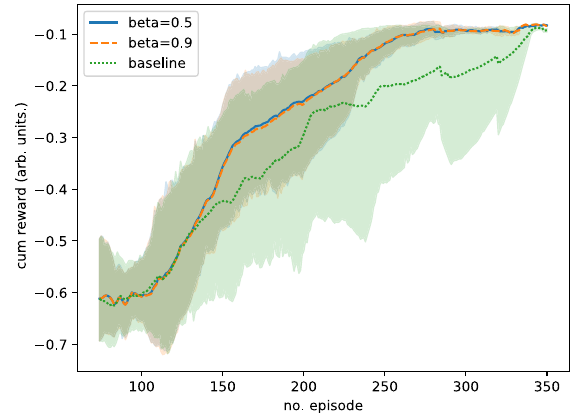
17. The training with prioritization of the samples for two different values of β compared to the baseline without